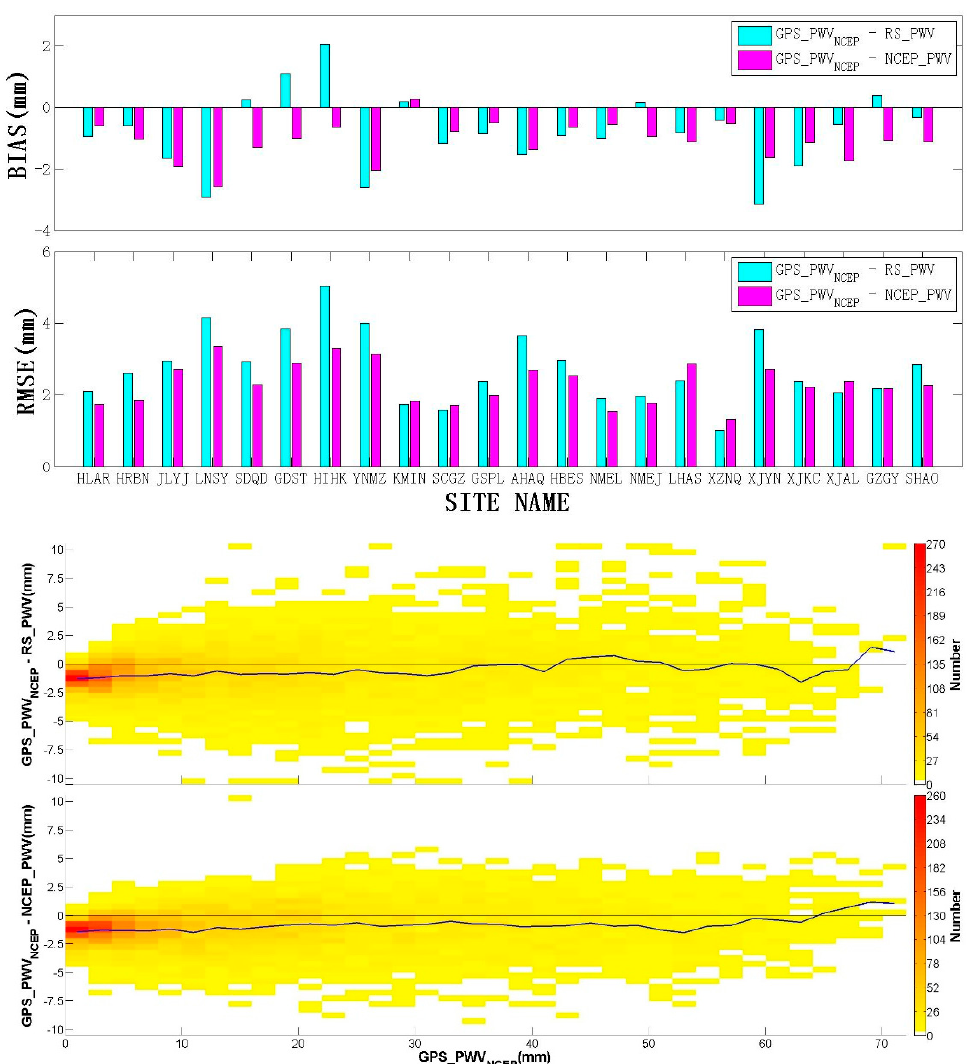
Figure 11. BIAS and RMSE at each GPS station ( top ); and number density plot of differences ( bottom ) between GPS_PWV NCEP and RS_PWV or NCEP_PWV. Remote Sens. 2016 , 8 , 389